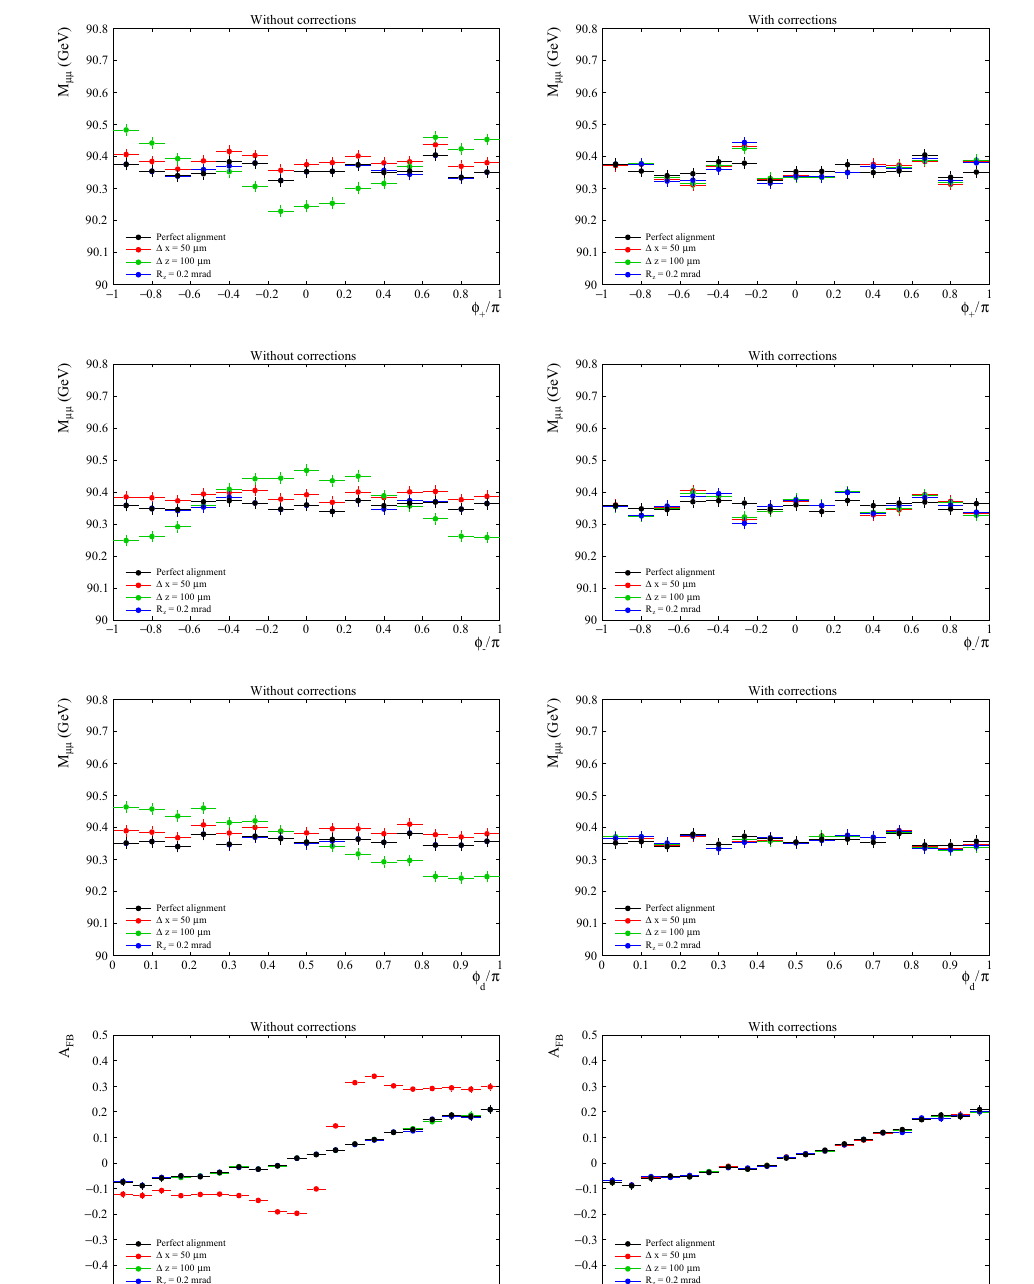
Fig. 7 Thefirstthreerowsshowtheprofilesofthemeandimuoninvari- mis-alignment scenarios. The left and right columns correspond to the ant mass in bins of φ + , φ − and φ d . The lower row shows the A FB val- simulation before and after application of the pseudomass corrections, ues in bins of mass. The black points correspond to the simulation with respectively no mis-alignment while the other colours correspond to the first three interest ( m W + , m W − and sin 2 θ eff ) 90 toy measurements are lept